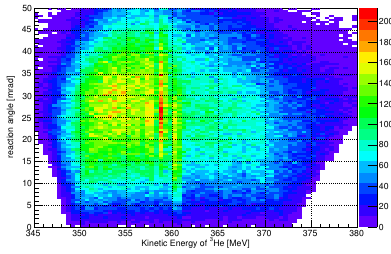
Fig. 4. Measured reaction angle as function of the kinetics